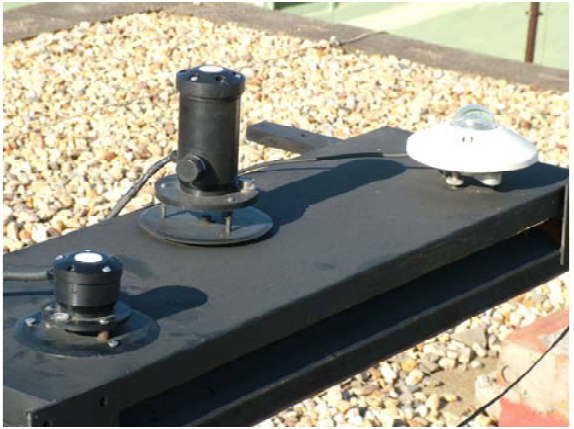
Figure 8. Location for calibrating the two pyranometers constructed, in relation to the standard pyranometer.